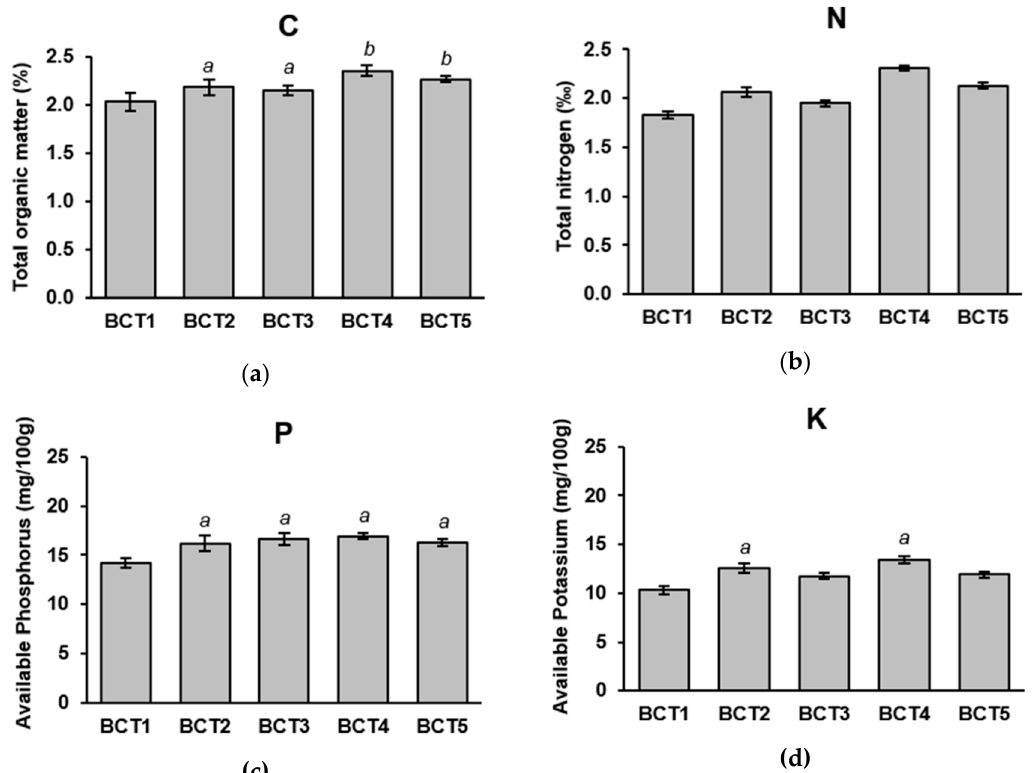
Figure 2. The contents of total organic matter ( a ), total nitrogen ( b ), available phosphorus ( c ) and available potassium ( d ) in the soil at the 4th cultivating year by biochemical treatments. BCT, biochemical treatment. Bars show means ± SD. Bars with the same letters are not statistically different based on the least significant difference at p < 0.05.